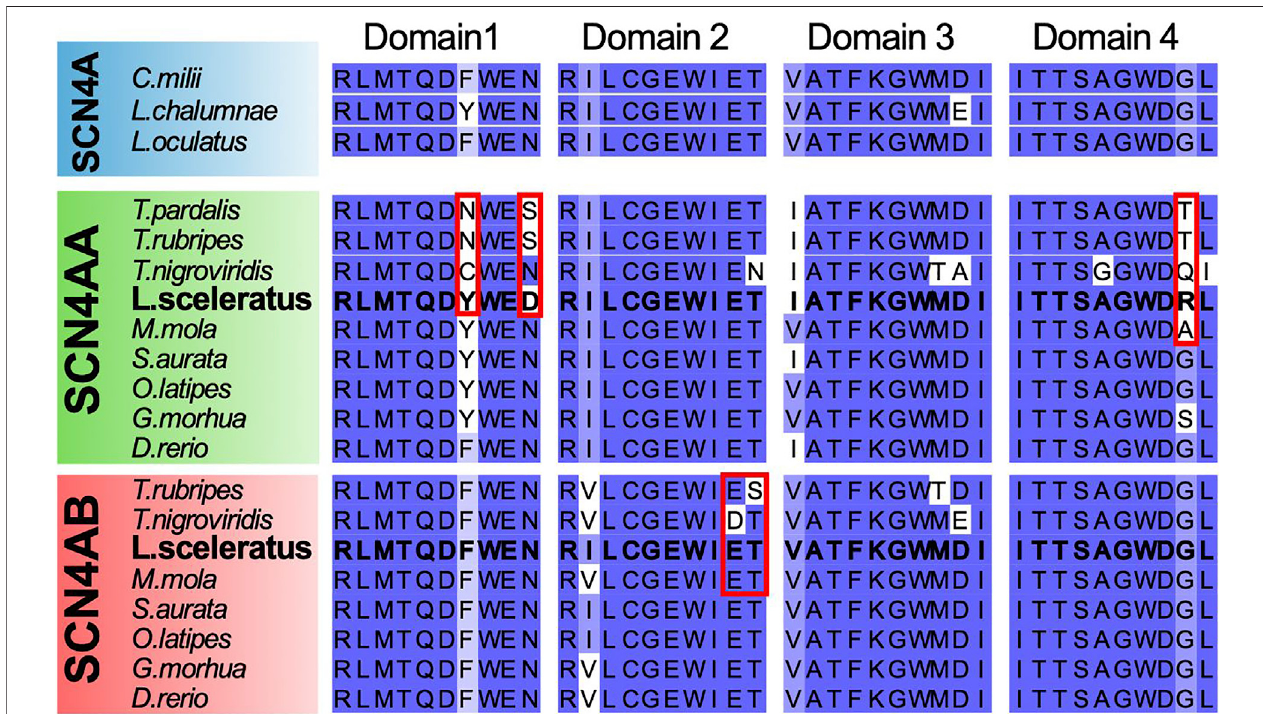
FIGURE 6 | Multiple alignment plot of the four Ion Transport domain sequences previously studied by Venkatesh et al. (2005), from Latimeria chalumnae (NaV1.4), Lepisosteus oculatus (NaV1.4), Callorhinchus milii (NaV1.4), T. pardalis (NaV1.4a), T. rubripes (NaV1.4a, NaV1.4b), T. nigroviridis (NaV1.4a, NaV1.4b), L. sceleratus (NaV1.4a, NaV1.4b), M. mola (NaV1.4a, NaV1.4b), S. aurata (NaV1.4a, NaV1.4b), O. latipes (NaV1.4a, NaV1.4b), M. morhua (NaV1.4a, NaV1.4b), and D. rerio (NaV1.4a, NaV1.4b). Residues outlined in red, have been previously associated with TTX resistance in T. rubripes and T. nigroviridis by Venkatesh et al.